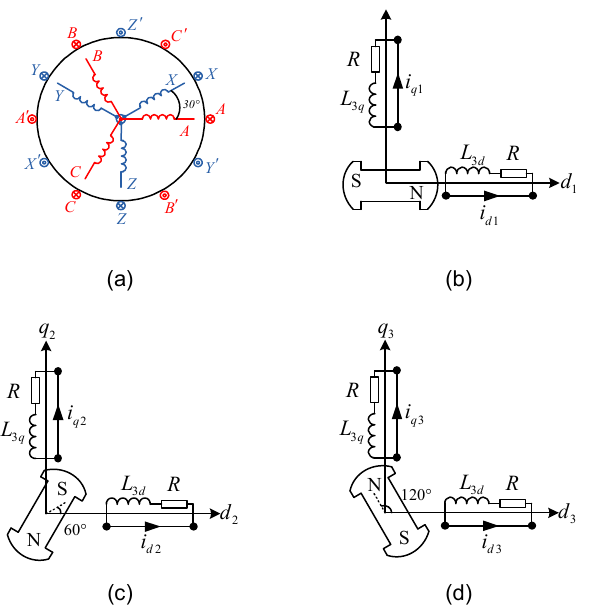
Figure 2. Decoupled three d-q coordinates, ( a ) dual three-phase windings, ( b ) d1-q1 reference frame; ( c ) d2-q2 reference frame; ( d ) d3-q3 reference frame.